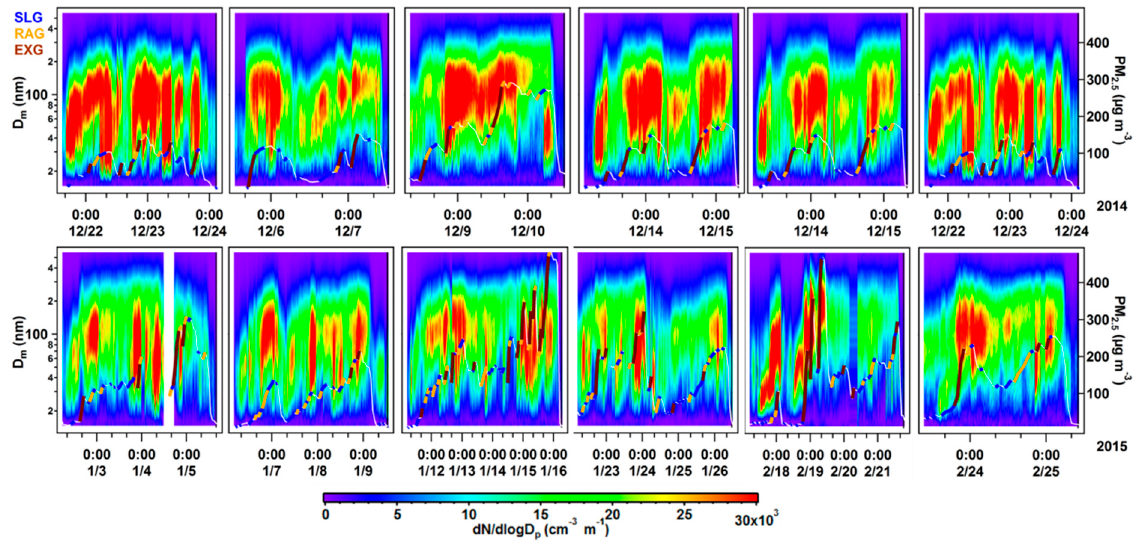
Figure 7. The number concentration spectrum distribution and temporal evolution of PM 2.5 mass concentration (right axis) during PM 2.5 episodes in 2014 ( top ) and 2015 ( bottom ) in Beijing. The colors of PM 2.5 mass concentration represent slow, rapid, and explosive growth. The white line indicates the concentration drop phase.